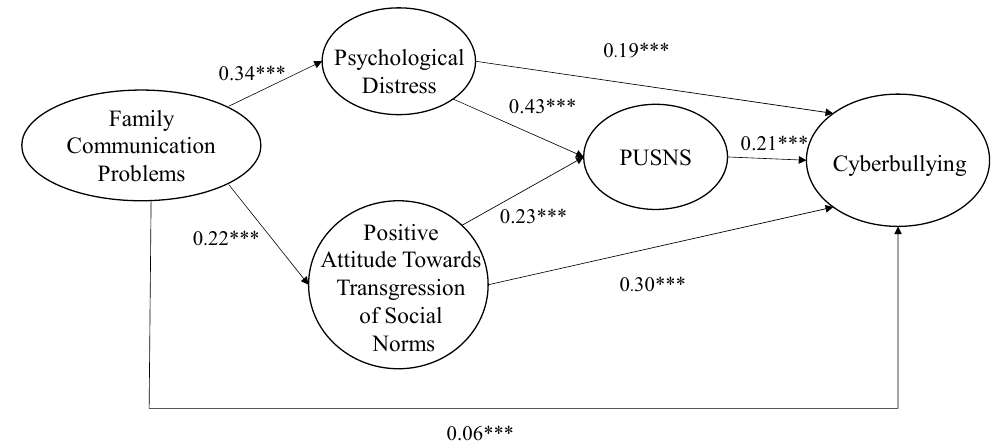
Figure 2. Final structural model with relation coefficients and statistical significance; *** p < 0.001.